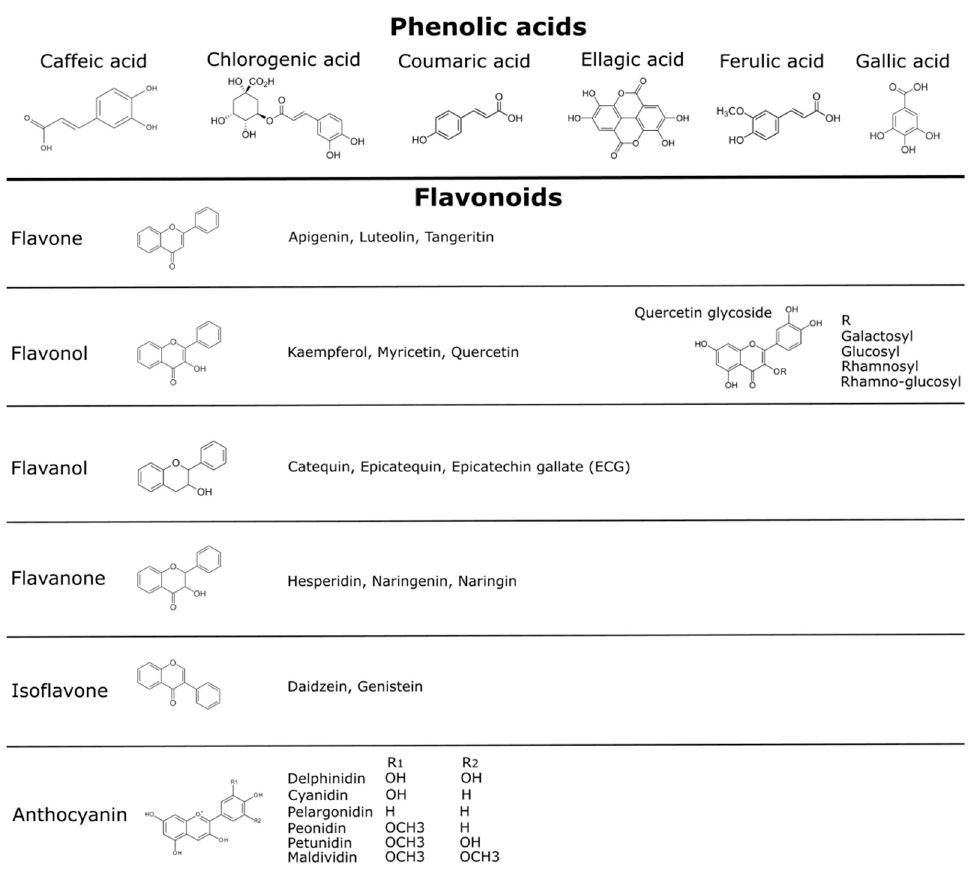
Figure 2. Polyphenols compounds described in vegetables and fruits. Different phenolic compounds have been reported in native Chilean berries, including phenolic acid, flavonoids such as quercetins—principally quercetin glycosides—and anthocyanins [15–23]. More details are presented in the text. Chemical structures credits [68].